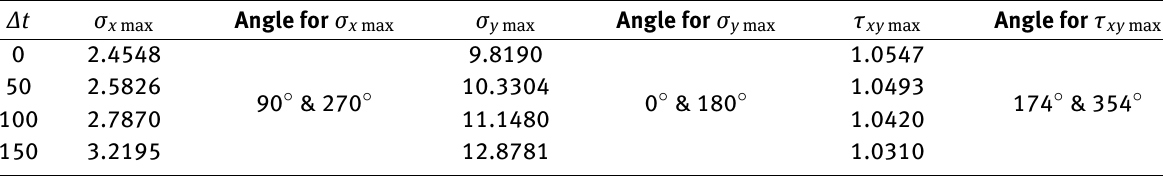
Figure 5: Stress distribution around elliptical hole in composite laminate plate subjected to equibiaxial tension with stacking sequence [ − 43.3204871 ∘ /88.4927171 ∘ /34.1990231 ∘ /45.1948441 ∘ / − 68.3984651 ∘ / − 89.9608541 ∘ / 73.1113401 ∘ / − 43.0827171 ∘ ] s (a) Present solution and (b) Sharma [11] Table 1: Effect of ∆t on σ x max